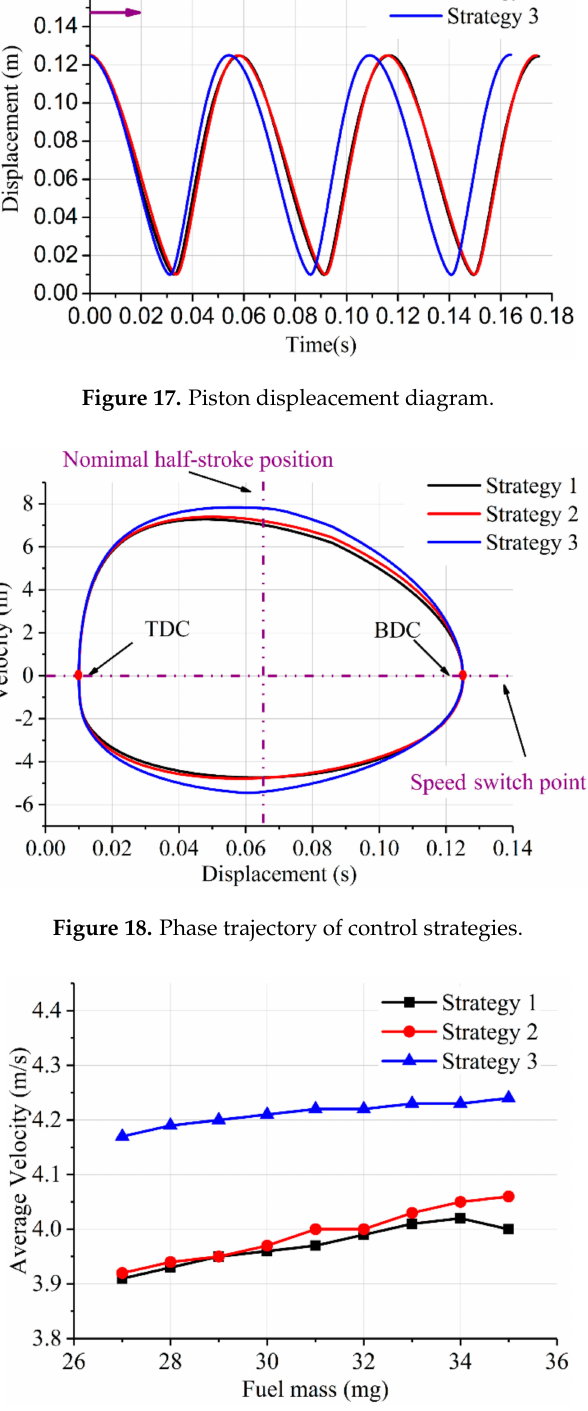
Figure 19. Piston average velocity with three control